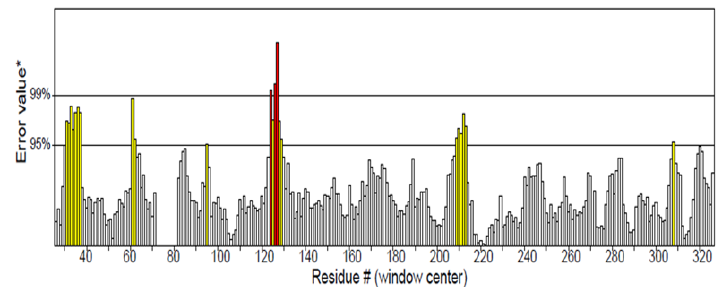
Figure 2. ERRAT plot for model LOX structure [Program: ERRAT2, Overall quality factor *: 95.392]. Table 2. Binding affinity for docked poses using AutoDock Vina.